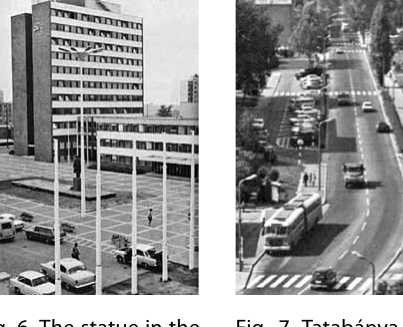
fig. 7. Tatabánya new town; the square fig. 6. The statue in the adjacent to the main axis with a statue in middle of the main square its centre of Sztálinváros serves as a visual closing for the urban axis starting at the railway station